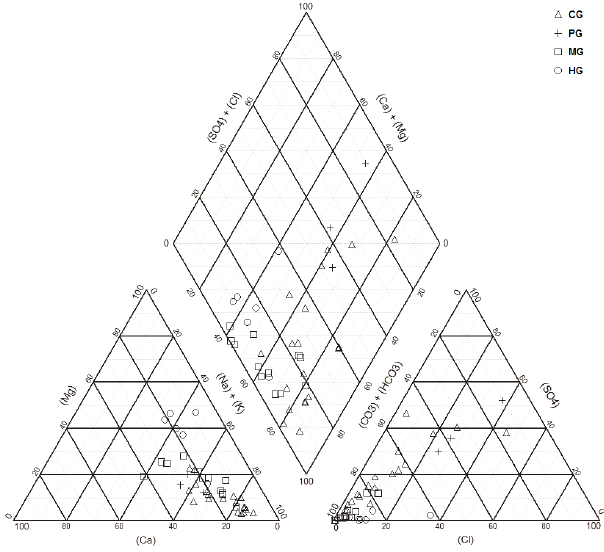
Figure 5. Piper diagram of groundwater samples from the Atemajac–Toluquilla aquifer system with well groups.